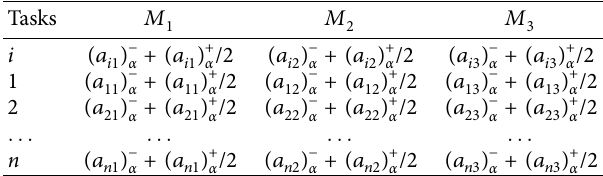
Table 4: The problem with the corresponding crisp matrix